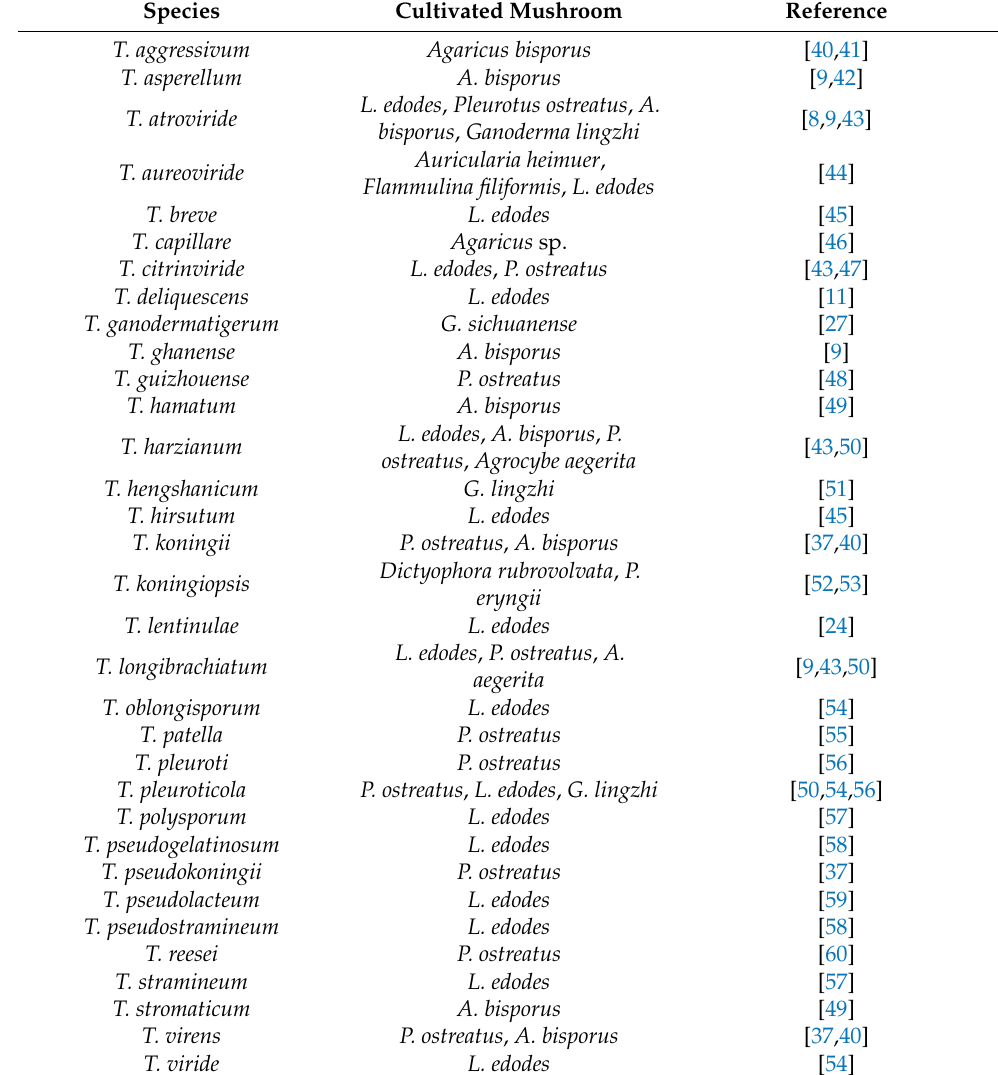
Table 2. Trichoderma spp. associated with the contaminated substrates of edible fungi.